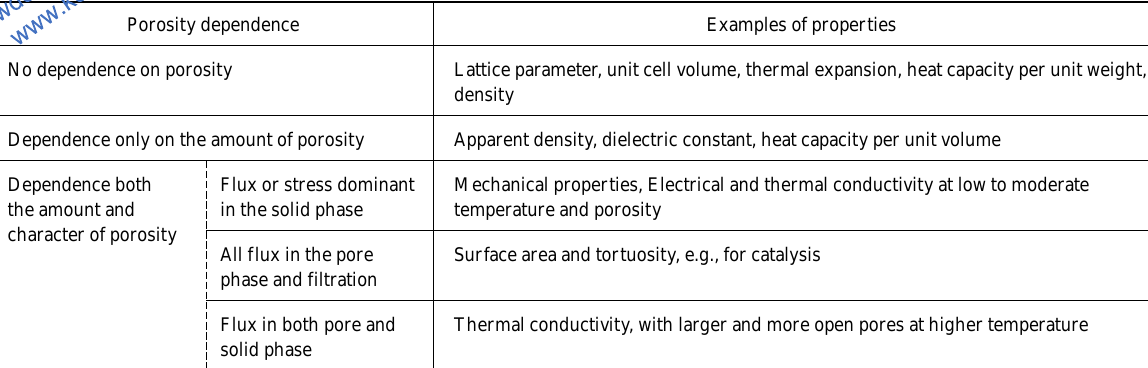
Table 1 Influence of porosity on properties (From Rice